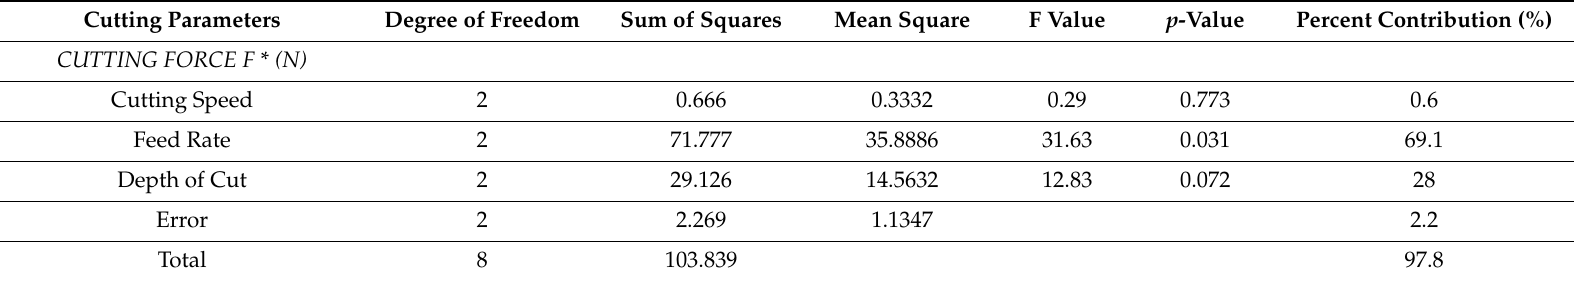
Table 6. ANOVA results for sensorial data, namely cutting force, AE, temperature, vibration and motor